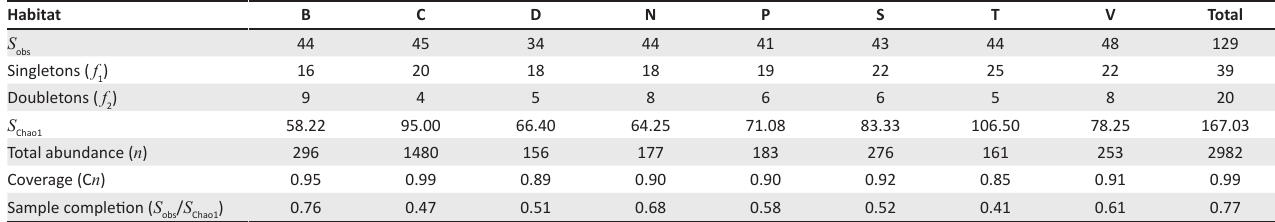
TABLE 3: Summary of actual and estimated species richness of ground-dwelling spiders sampled by pitfall trapping from eight habitats in the Amanzi Private Game Reserve.